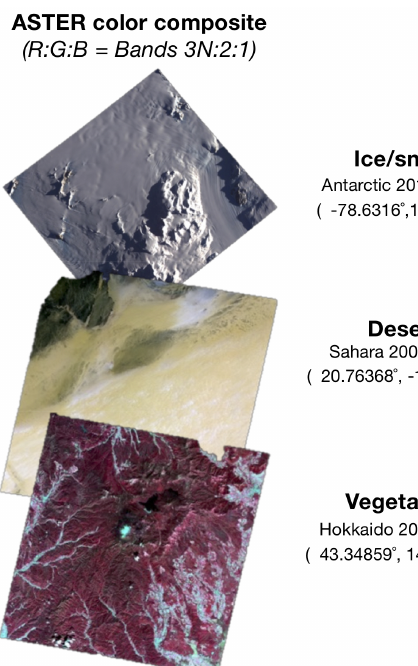
Figure 1. Normalized spectral response functions of ASTER (solid line) and MODIS (dotted lines) VNIR bands.